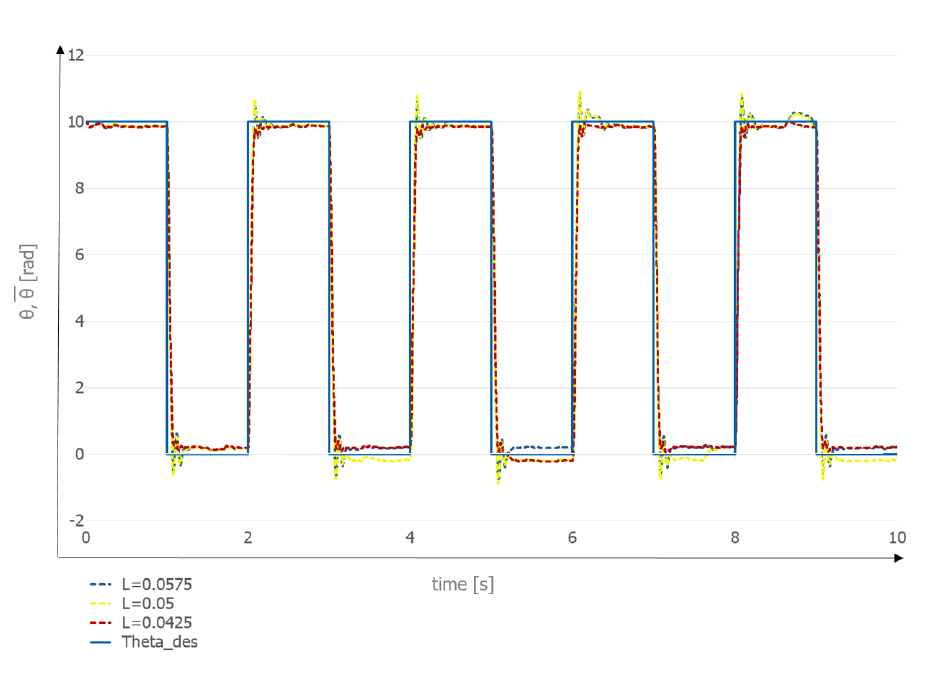
Figure 14. Co-simulation runs for different values of inductance (in